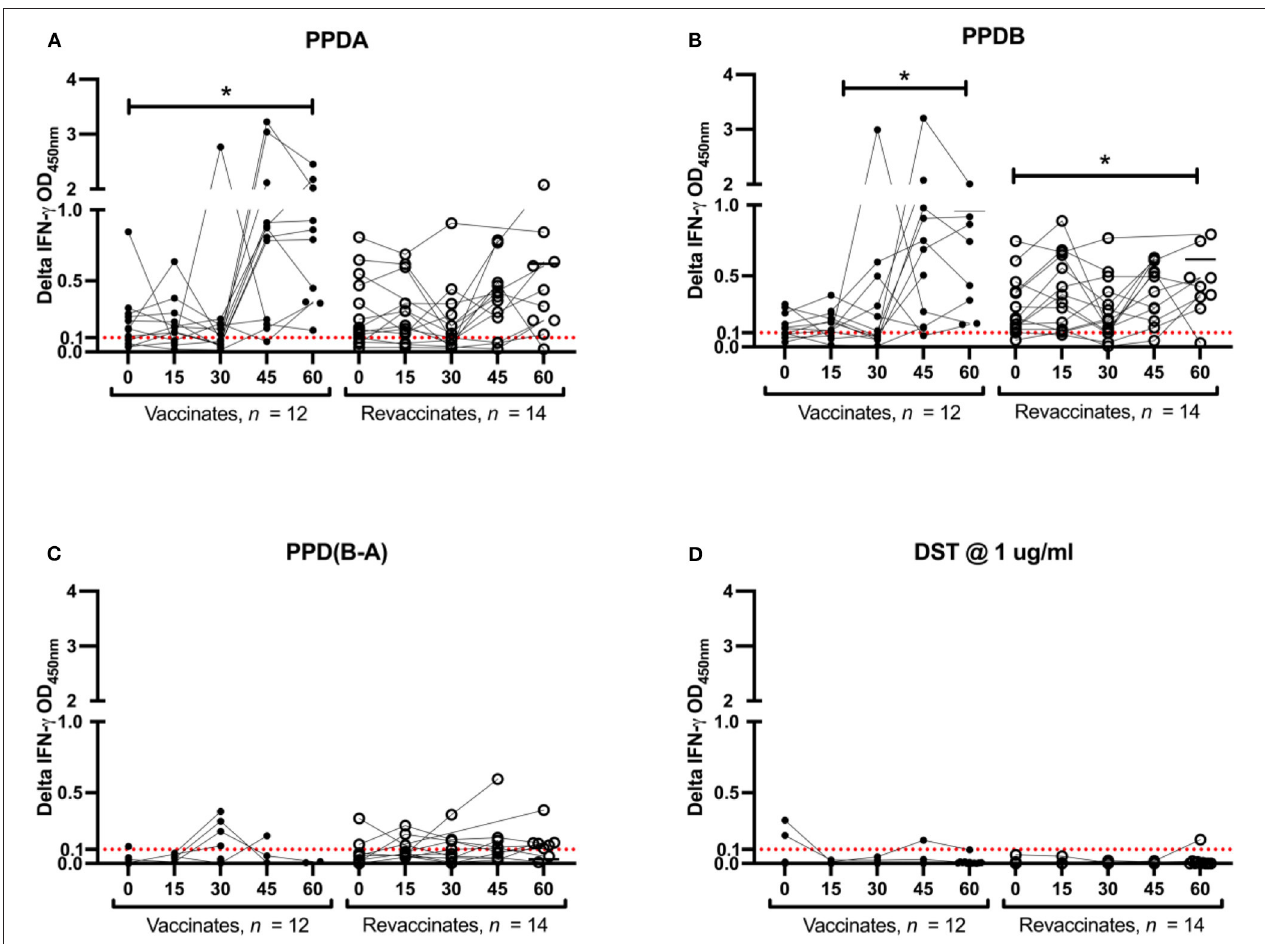
FIGURE 2 | PPDs- and DST-stimulated IFN- γ responses following Bacillus Calmette–Guérin (BCG) vaccination. In vitro IFN- γ responses of BCG vaccinates (closed circle, n = 12) and revaccinates (open circle, n = 14) to (A) PPD-A, (B) PPD-B, (C) PPD(B-A), and (D) DST. Results are expressed as background-corrected (delta) optical density (OD) values. Days post-BCG are shown in the x-axis. All calves were vaccinated with BCG on day 0. Blood was collected for interferon-gamma release assay (IGRA) just prior to injection of BCG on day 0, and on days 15, 30, 45, and 60 post-vaccination. The differences in responses induced between the various timepoints were determined using Tukey’s multiple comparison test (* p < 0.05). The IGRA cutoff of 0.1 is shown as a dotted red